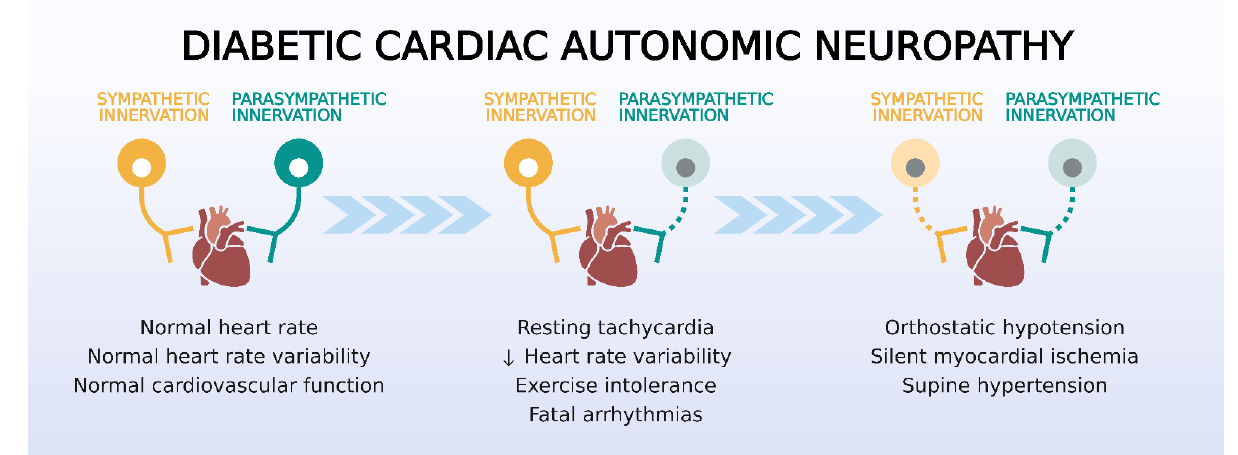
Figure 1. Evolution of symptoms of cardiac autonomic neuropathy (CAN) in diabetes. Patients display reduced variability in heart rate and resting tachycardia in the early phase of parasympathetic dysfunction, which underlie the reduced exercise tolerance and the increased arrhythmogenesis. Later stages of CAN involve sympathetic denervation and cause hemodynamic dysregulation and silent myocardial ischemia. Source: Own authorship.